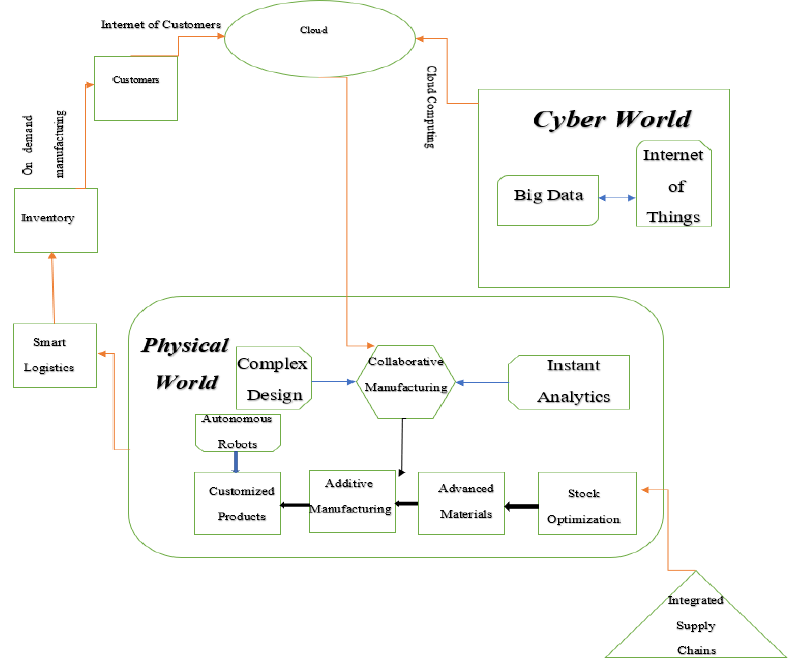
Figure 19. Multi ‐ level graph of Industry 4.0 .